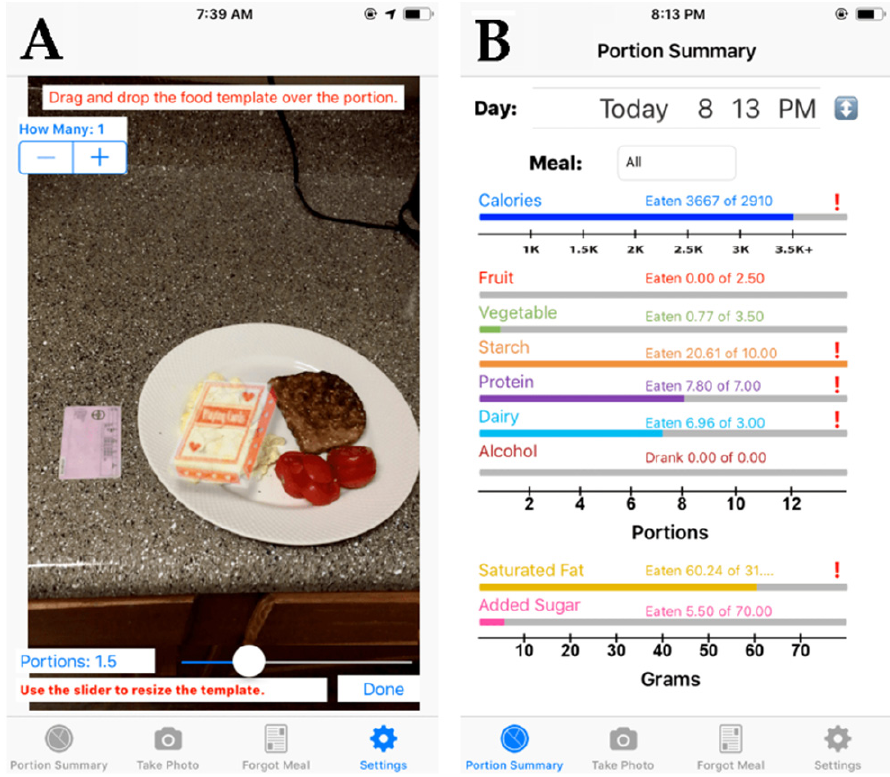
Figure 1. Screenshots from the PortionSize ® app illustrating an example in which a template that looks like a deck of cards was placed over scrambled eggs to estimate their portion size ( A ) as well as an example of the real-time feedback (calories and nut and nutrient composition of the meal and the overall diet) provided by the PortionSize ® app after the automatic portion size estimation ( B ).